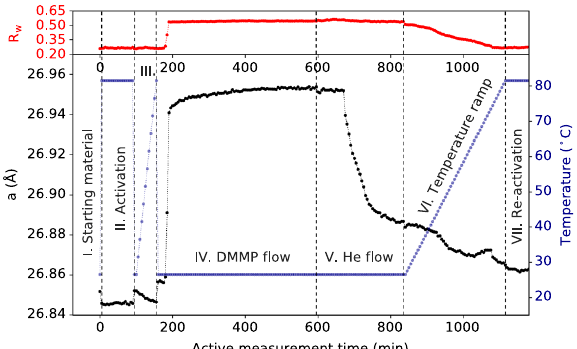
Fig. 2 Lattice parameters from re fi nement. Lattice parameter a (black dots, left axis) during steps I – VII with respect to active measurement time (5 min increments: only continuous within a given experimental step). Dashed vertical lines represent time breaks between steps. The temperature (blue dots, right axis) and goodness-of- fi t R w from real-space structure re fi nement (red dots, top) are given for every data point.